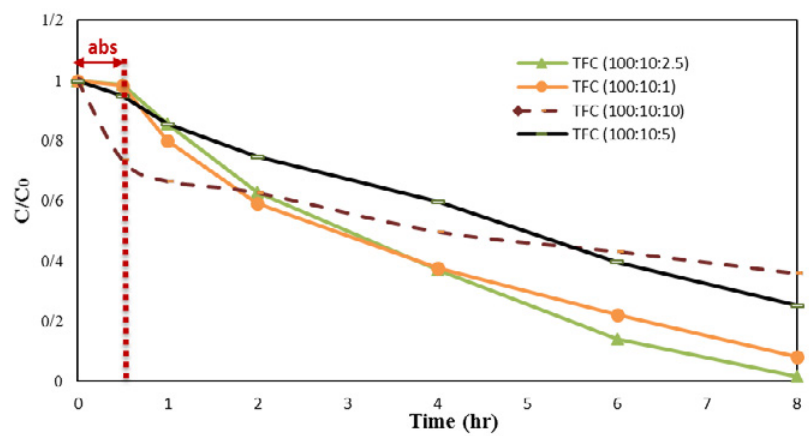
Fig. 4. Investigating the ratio of composition of TiO 2 /Fe 3 O 4 / MWCNT (Nanocomposite dosage = 0.5 g/L, dye concentration = 50 ppm, DO = 7/4 mg/L, pH= 7)